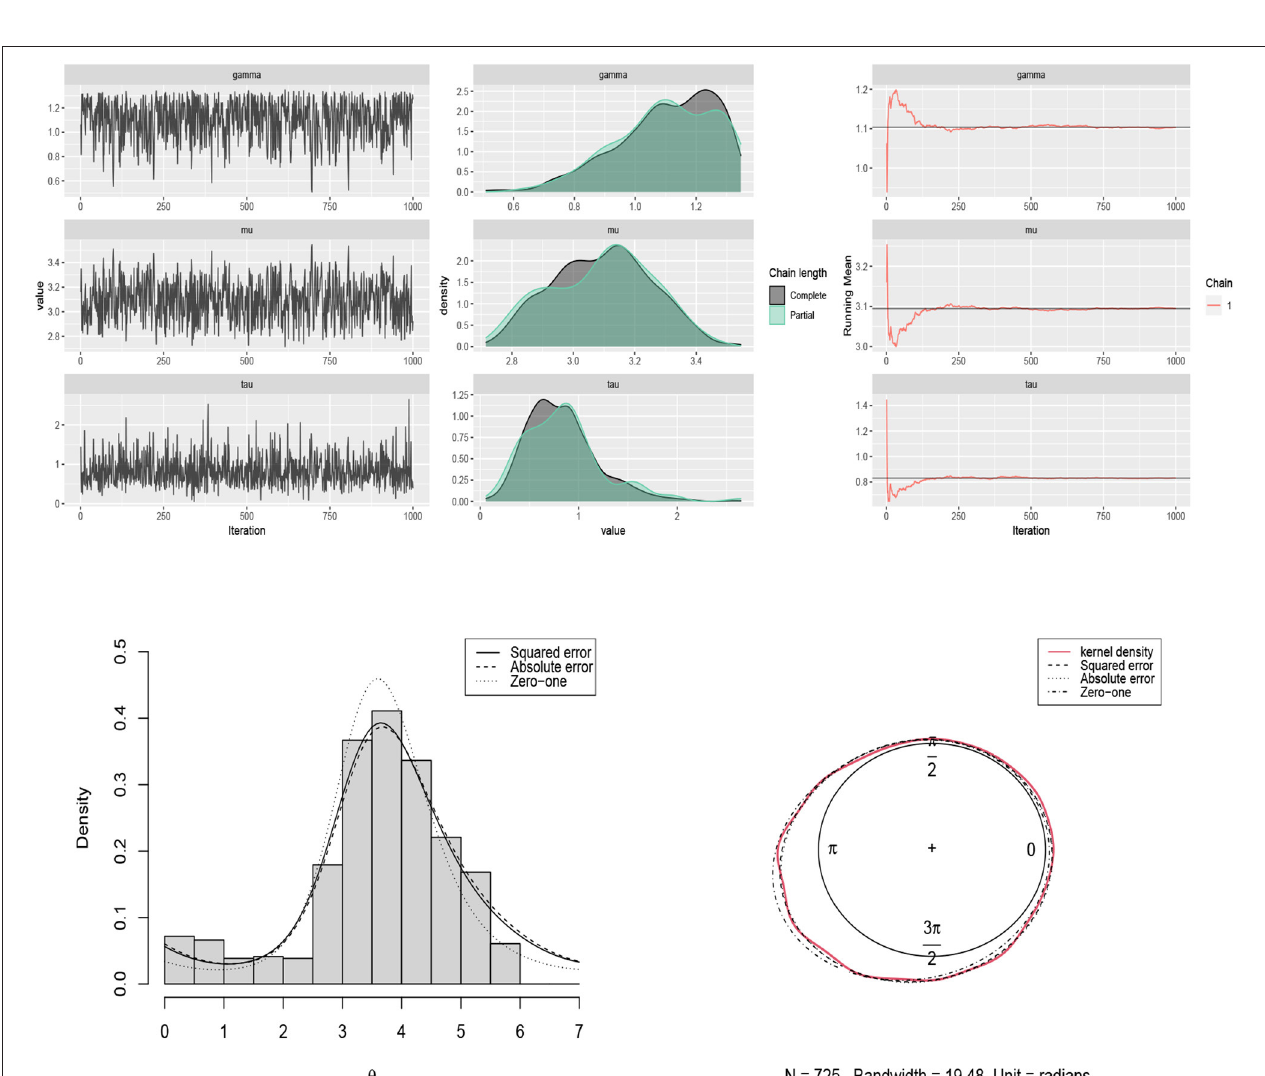
FIGURE 10 | (Top) traceplots, mean running and estimated posterior pdf plots of generated samples for ( µ , τ , γ ) in Table 4 for the thunder at Kew dataset. (Bottom) the histogram and kernel density plot of the data related to the thunder at Kew and the fitted curves under different loss functions.